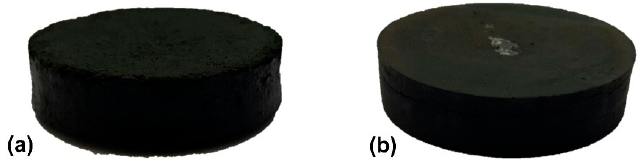
Figure 1. High-pressure composite prepared from plant residue and: ( a ) Phenol-furfural resin; ( b ) Phenol-furfural resin/organo modified montmorillonite (MMT) clay composite.